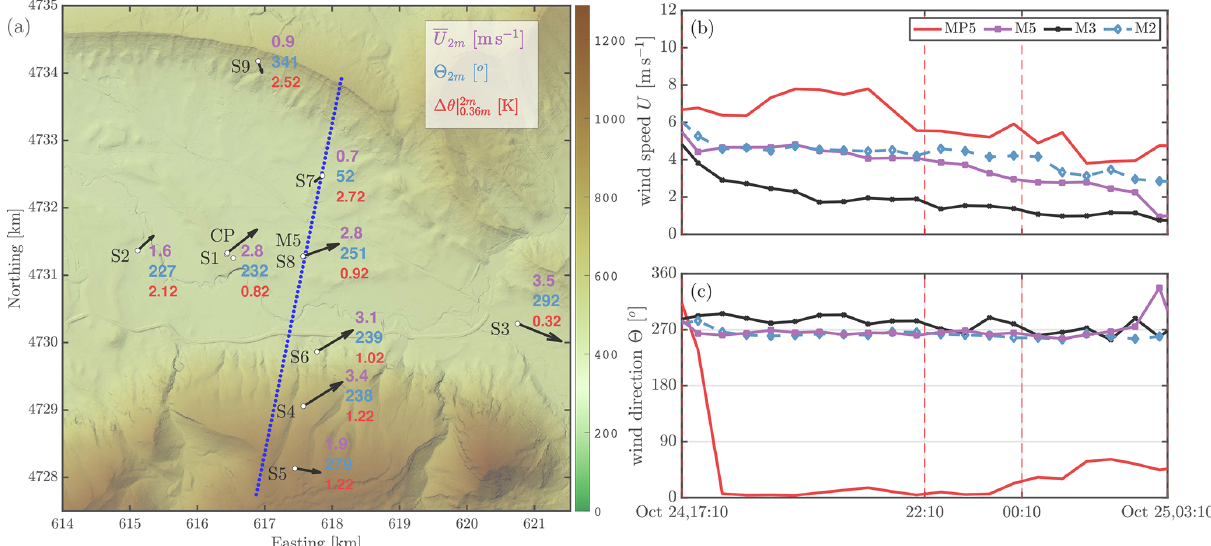
Figure 13. Panel (a) shows surface-layer stations’ wind speed ( U 2m ) and wind direction ( (cid:50) 2m ), both at 2m and potential temperature gradient between 0.36 and 2m ( (cid:49)θ ) at 24 October 2018 22:30Z. Panels (b) and (c) show the time series of wind speed and direction from the masts, respectively. The vertical dashed lines represent the snapshots of Fig.